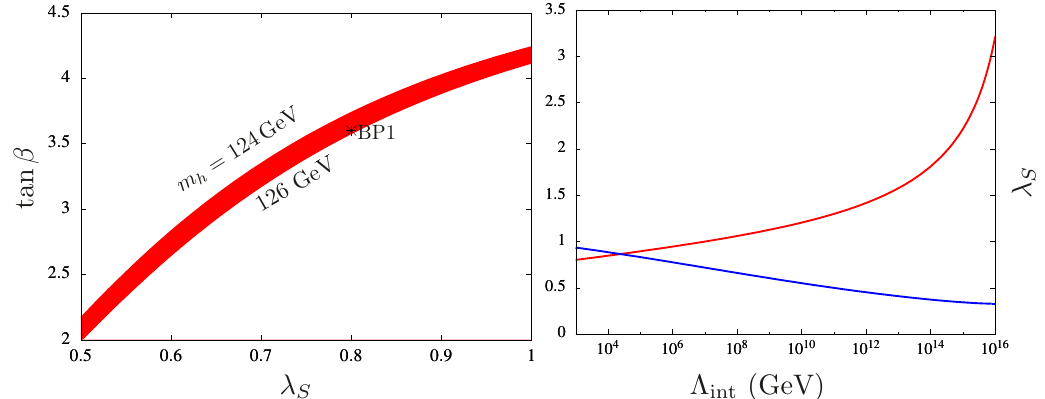
Figure 10 . Left: Higgs mass with new tree level quartic contributions after taking into account two loop corrections from the stop sector ( ~ m ~ 1 : 8 TeV). The MSSM tree level contribution is depleted t (cid:24) due to our choice of M (cid:6) and M D ’s (same as BP1). However, additional F -term contributions occur from the superpotential coupling (cid:21) S . Right: running of superpotential coupling (cid:21) S (shown by the red-solid curve on the left panel) and top Yukawa coupling (blue-solid curve). We have (cid:12)xed (cid:21) ( (cid:22) IR ) = 0 : 8 and tan (cid:12) = 3 : 6 (same as BP1) to satisfy Higgs mass constraints. 1 : 8 TeV). The MSSM tree level contribution gets reduced due to the presence of M (cid:6) and i M D , however additional F -term contributions from the superpotential coupling (cid:21) S i